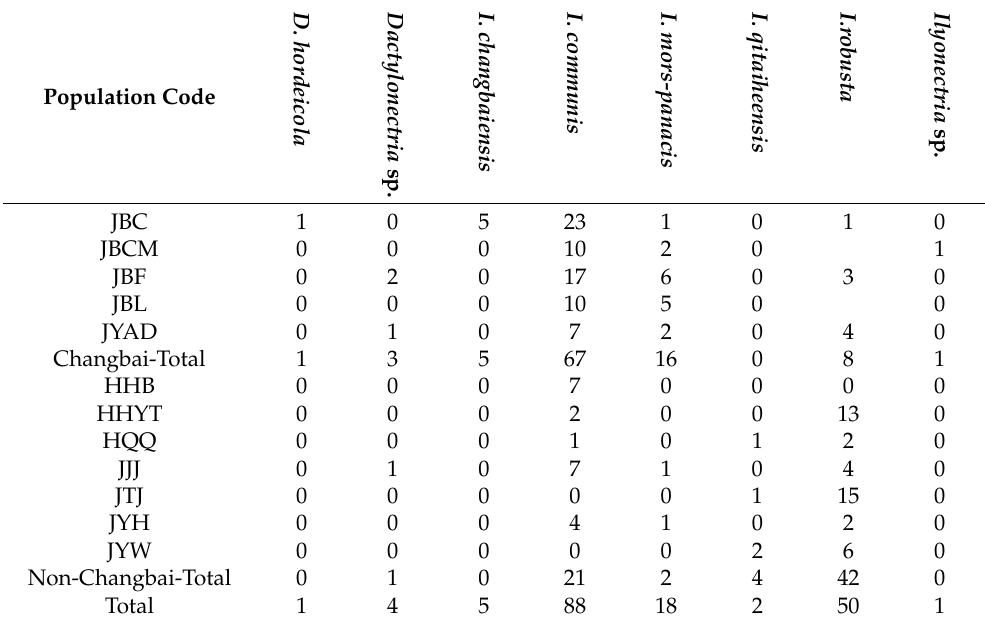
Table 2. Cylindrocarpon -like fungi species